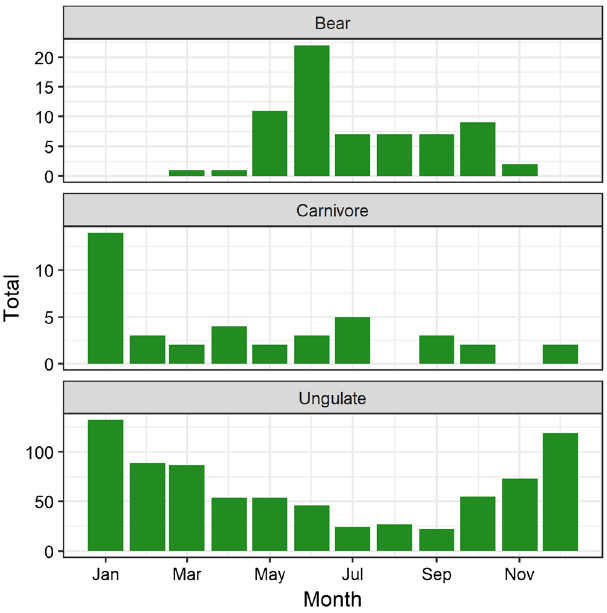
Figure 3. Total cumulative mortalities by month between 1995 and 2018 for three guilds of large mammals struck on the railway through Banff and Yoho National Parks, Canada.